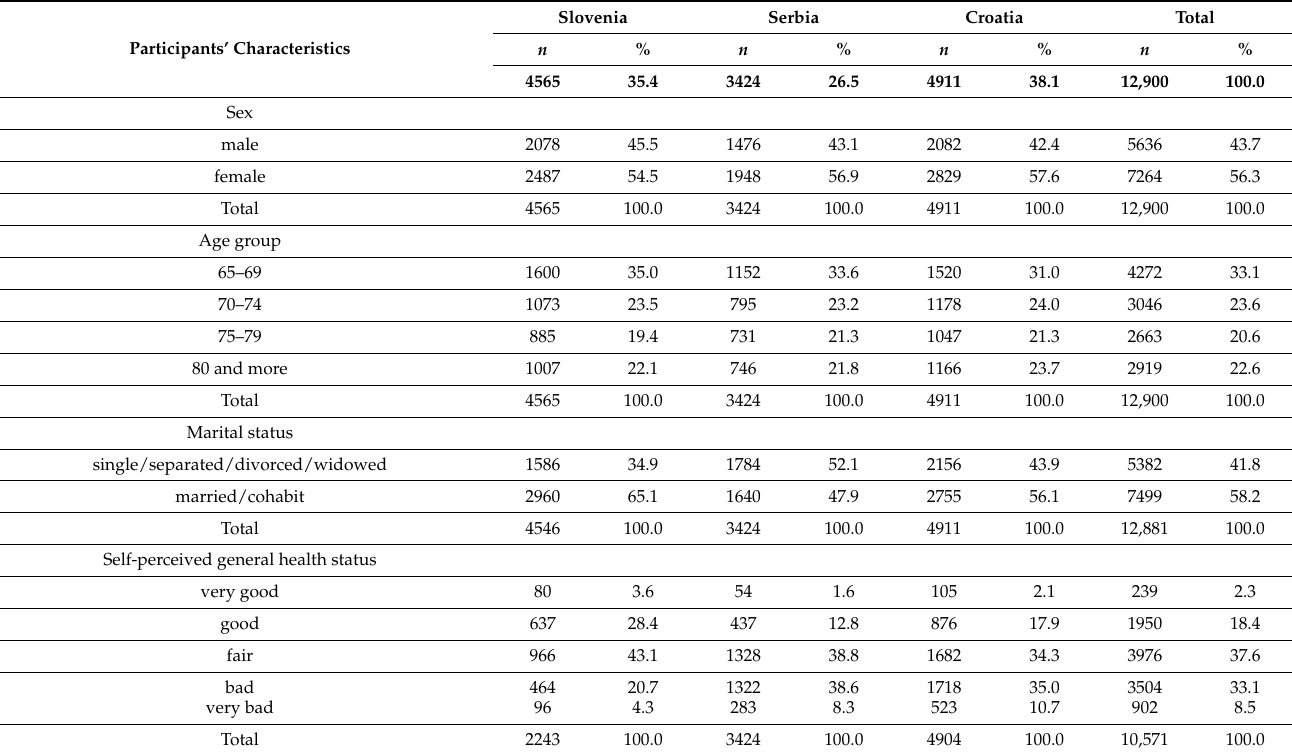
Table 2. Individual and household characteristics of the older-aged participants from Slovenia, Serbia, and